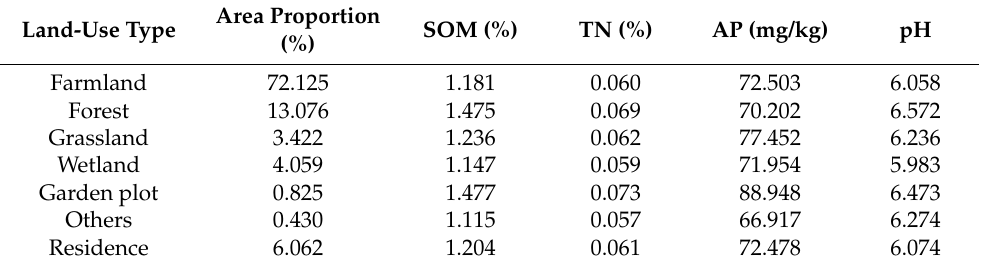
Table 3. The statistics of the indicators in different land-use type.